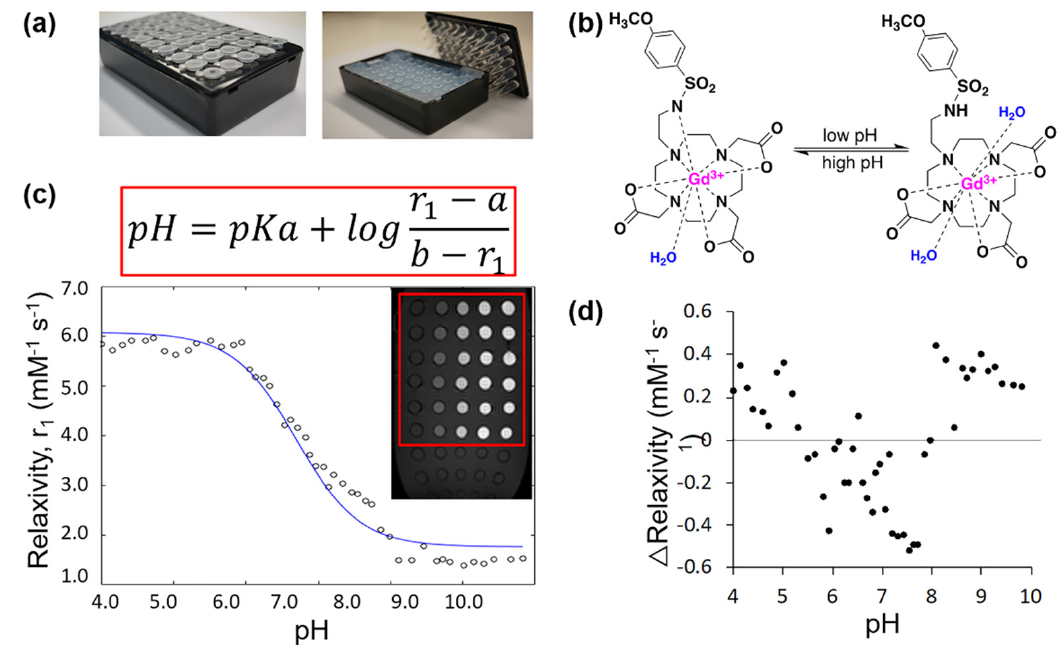
Figure 2. The MRI co-agent displayed pH-dependent relaxivities in a 7T MR scanner. ( a ) A phantom holder for pH-relaxivity calibration curve studies contained 2% agarose to reduce B0 and B1 inhomo- geneities. ( b ) The pH responsive MRI co-agent undergoes protonation of its sulfonamide arm at low pH values, which allows for an additional water to occupy the inner sphere and interact with the gadolinium core. This leads to an increase in the relaxation rate of bulk water. At high pH values, this arm is deprotonated and bound to gadolinium, which leads to a decrease in the relaxation rate of bulk water. ( c ) Relaxation rates were calculated from measured T 1 times of samples at various pH values and concentrations of the MRI co-agent. Relaxivities were calculated from the relaxation rates and concentrations, and the pH-relaxivity curve was fit to a modified Henderson–Hasselbach equation, where a is the r 1 relaxivity at complete agent protonation and b is the r 1 relaxivity at complete agent deprotonation. The image insert is a representative MR image of one sample box, where samples with increasingly higher concentrations of MRI co-agent appear increasing brighter towards the right side of the image. ( d ) The residuals of the fit of the pH-relaxivity curve demonstrated the good fit of the data.